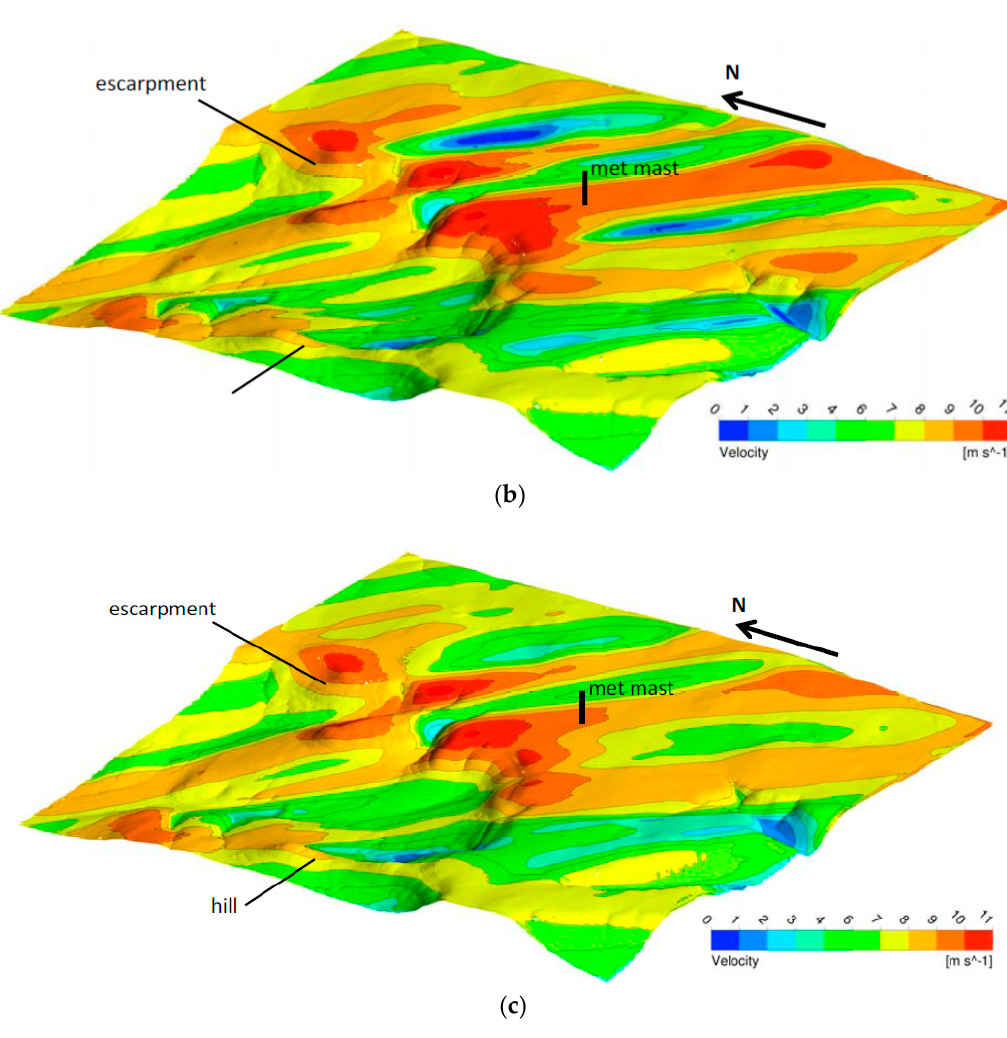
Figure 5. ( a ) Velocities computed with k- ε model on a height of 75 m above ground; ( b ) velocities computed with RNG k- ε model on a height of 75 m above ground; ( c ) velocities computed with RSM model on a height of 75 m above ground.